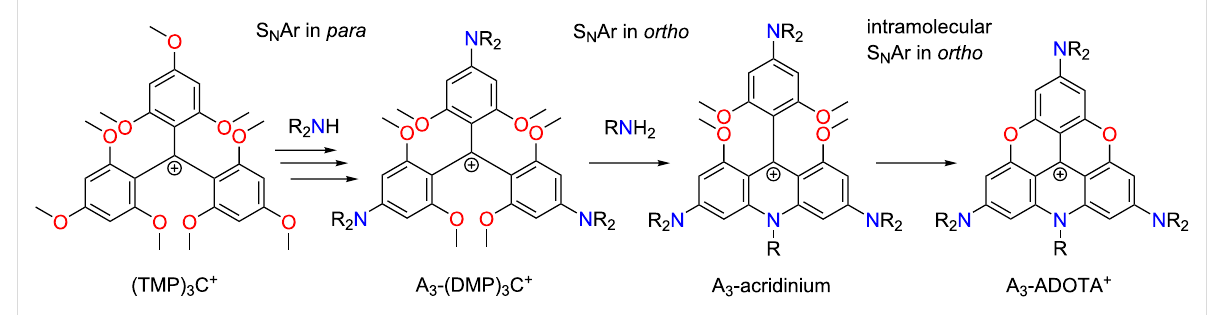
Figure 2: Examples of various types of S N Ar reactions typical in triangulenium synthesis, exemplified with the synthesis of A 3 -ADOTA + : step 1, replacement of p -methoxy groups with dialkylamines. Step 2, replacement of o- methoxy groups with a primary amine followed by intramolecular S N Ar reaction. Step 3, intramolecular S N Ar replacement of methoxy groups by hydroxy groups formed under ether-cleavage conditions.